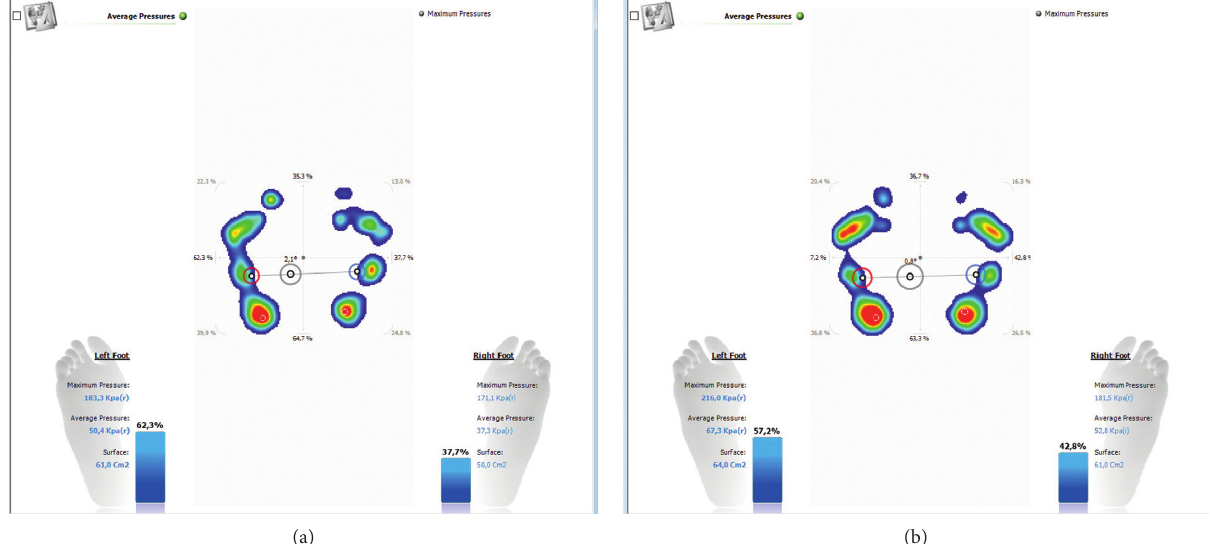
Figure 7: The exemplary result of the postural assessment of pressure distribution, in lateral and antero-posterior view measured (a) before and (b) after a therapeutic